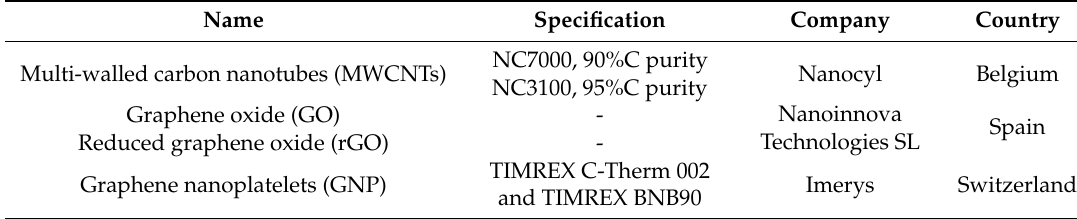
Table 1. Nanocarbon supports used in the project.